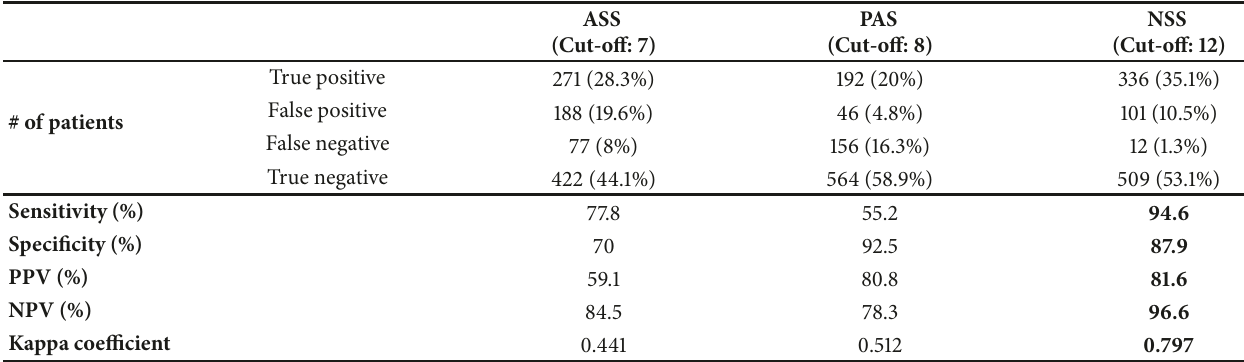
Table4:DiagnosticperformanceofASS,PAS,andNSS(PPV:positivepredictivevalue,NPV:negativepredictivevalue,ASS:AlvaradoScoring System, PAS: Pediatric Appendicitis Score, and NSS: New Scoring System).